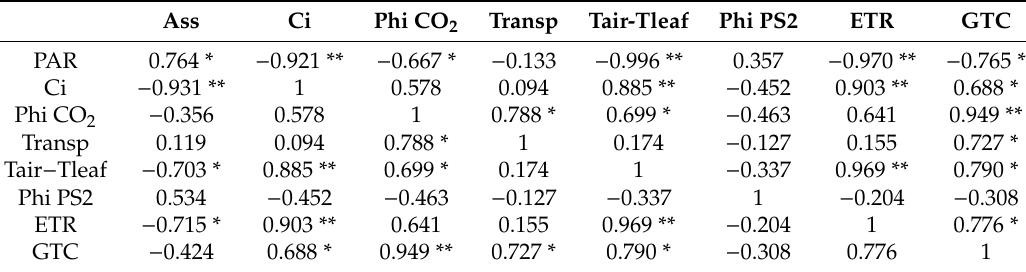
Table 4. Pearson correlation coe ffi cient values between PAR and assimilation parameters in winter barley (2020,